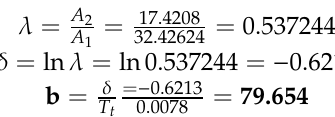
Figure 13. The comparison of damping in polymer concrete and U-shaped steel profile. It was also possible to substitute the U-shaped steel profile